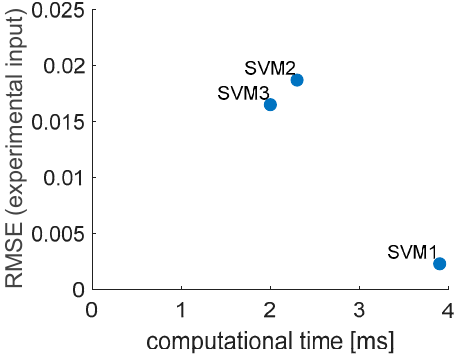
Figure 10. Graphical comparison of accuracy and computational time for obtained SVM models.